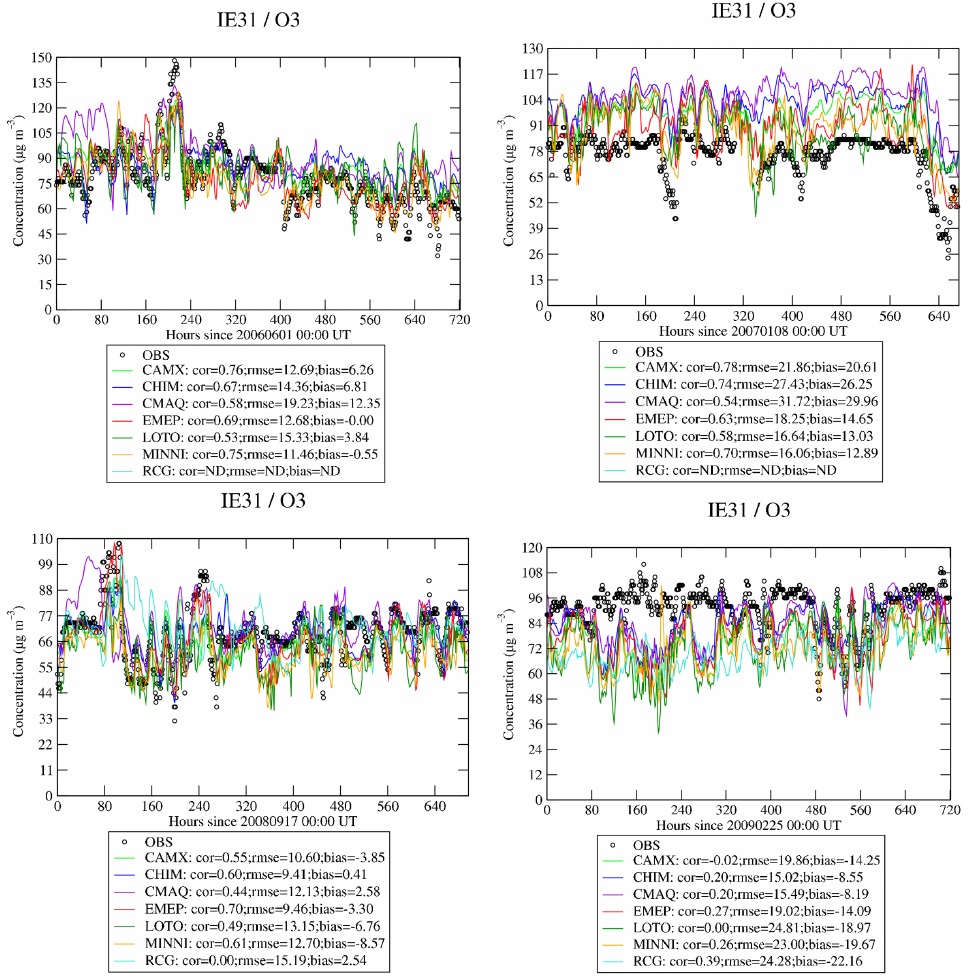
Figure 7. Time series of hourly concentrations at Mace Head for all models and campaigns